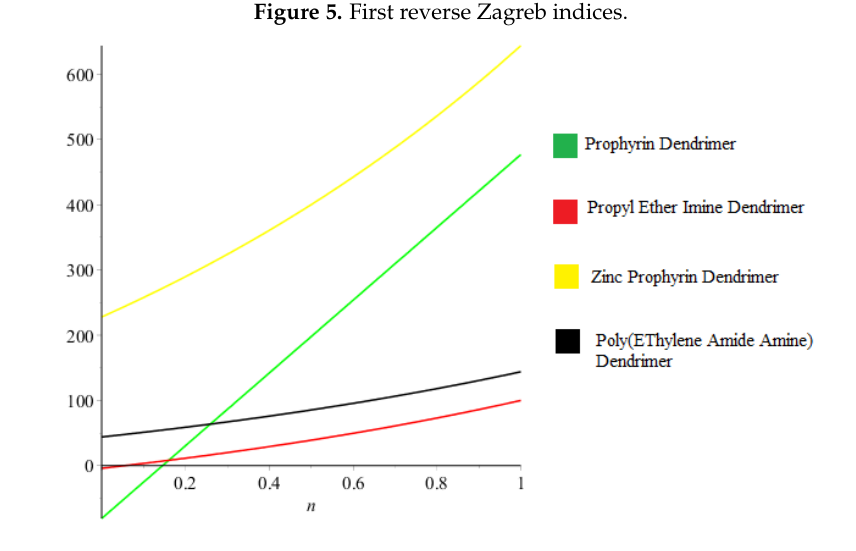
Figure 5. First reverse Zagreb indices.